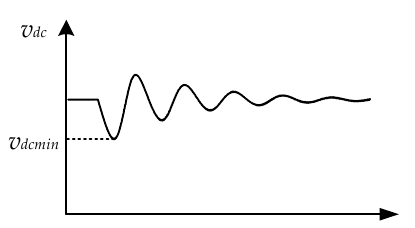
Figure 7. Bus voltage under large-signal disturbance (power sudden increase).